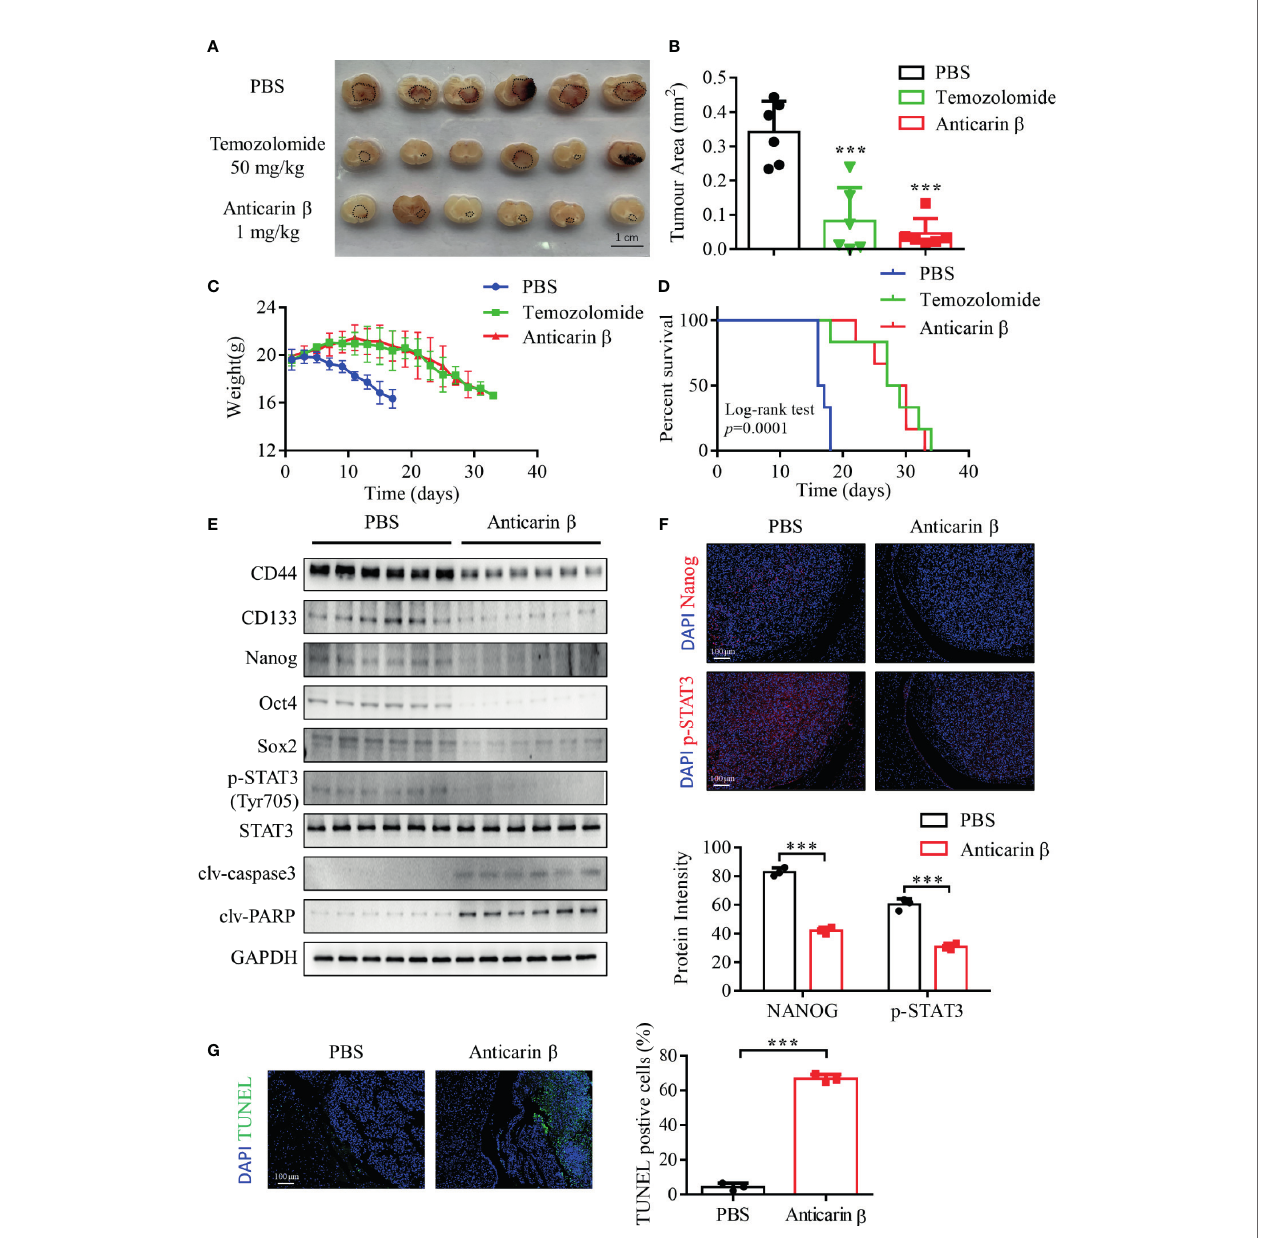
FIGURE 5 | Anticarin b inhibits the tumor growth of the human glioma orthotopic xenograft in vivo . U87-MG (2 x 10 5 ) cells were inoculated in the right hippocampus of NOD/SCID mice. 3 days post inject, the intracranial administration of PBS or anticarin b (1 mg/kg) using Alzet Osmotic Pumps was started on animals each day, and the intragastric administration of temozolomide (TMZ) (50 mg/kg) was started on animals once. All mice were used in vivo research after death. The tumor area was measured by brain sections, tumor areas are highlighted in black circles on the brain sections (A, B) , and the comparison of weight and Kaplan-Meier curves among each group is presented (C, D) . (E) Tumor samples were collected, and protein was extracted for western blot analysis. Stemness-related proteins and apoptosis proteins were detected, with GAPDH used as control. (F) Tumors were subjected to immuno fl uorescent stain and the level of Nanog and p-STAT3 was evaluated. Cells were stained for the DAPI (blue), Nanog (red), p-STAT3 (red). Scale bar, 100 m m. (G) Tumors were subjected to TUNEL assay and the percentage of TUNEL-positive cells were calculated. Data represent mean ± s.d. N = 6. *** P < 0.001 versus the Control